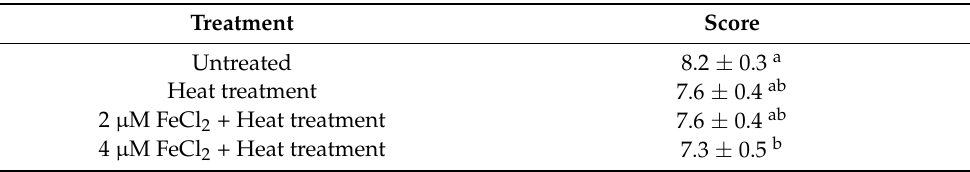
Table 3. Effect of Fe 2+ on aroma quality of catechins-removed green tea infusion.